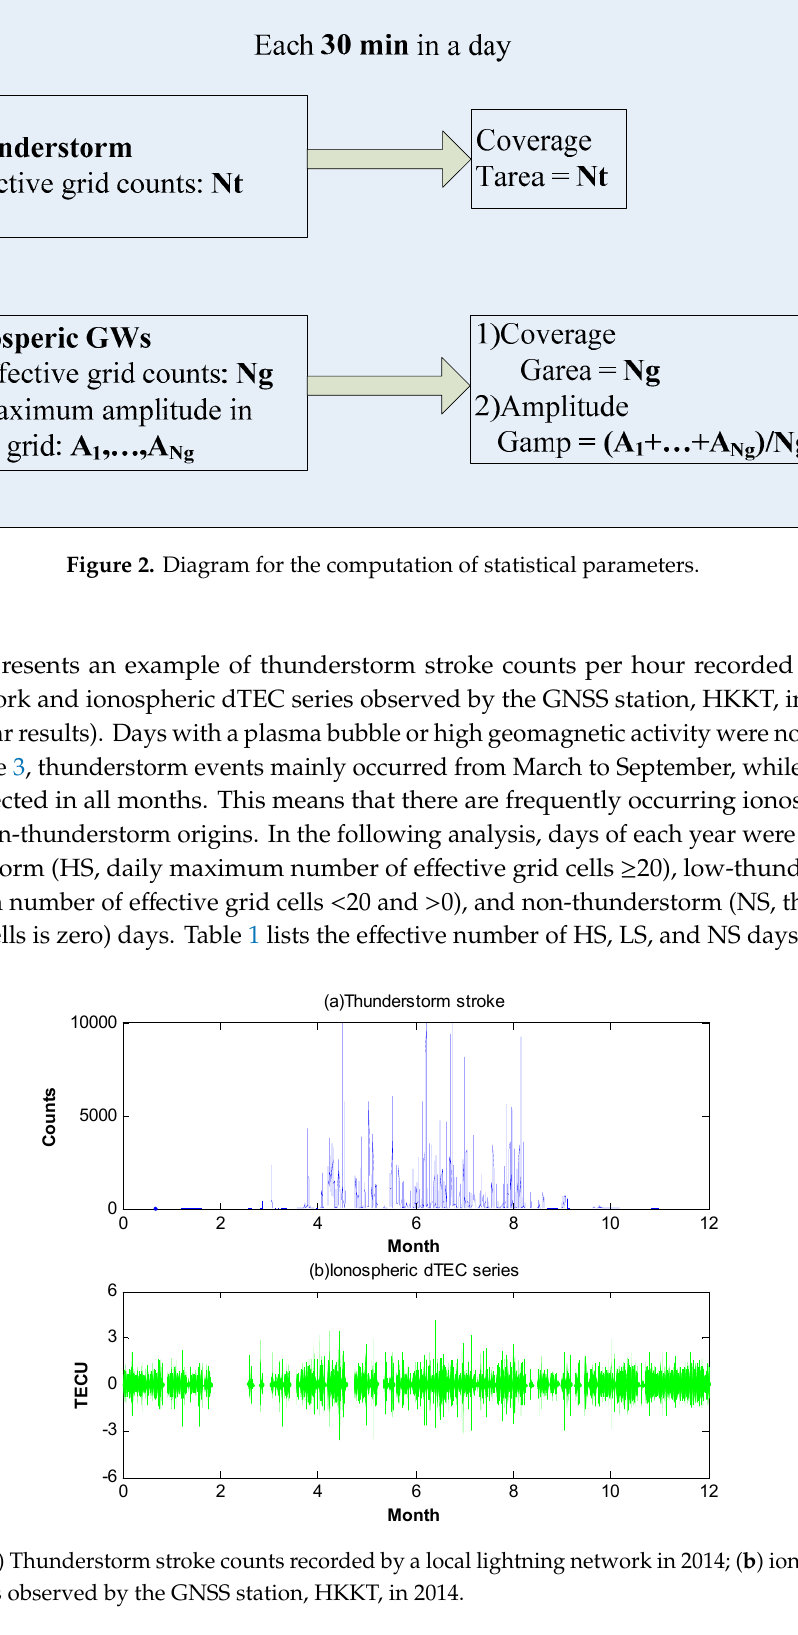
Figure 2. Diagram for the computation of statistical parameters.